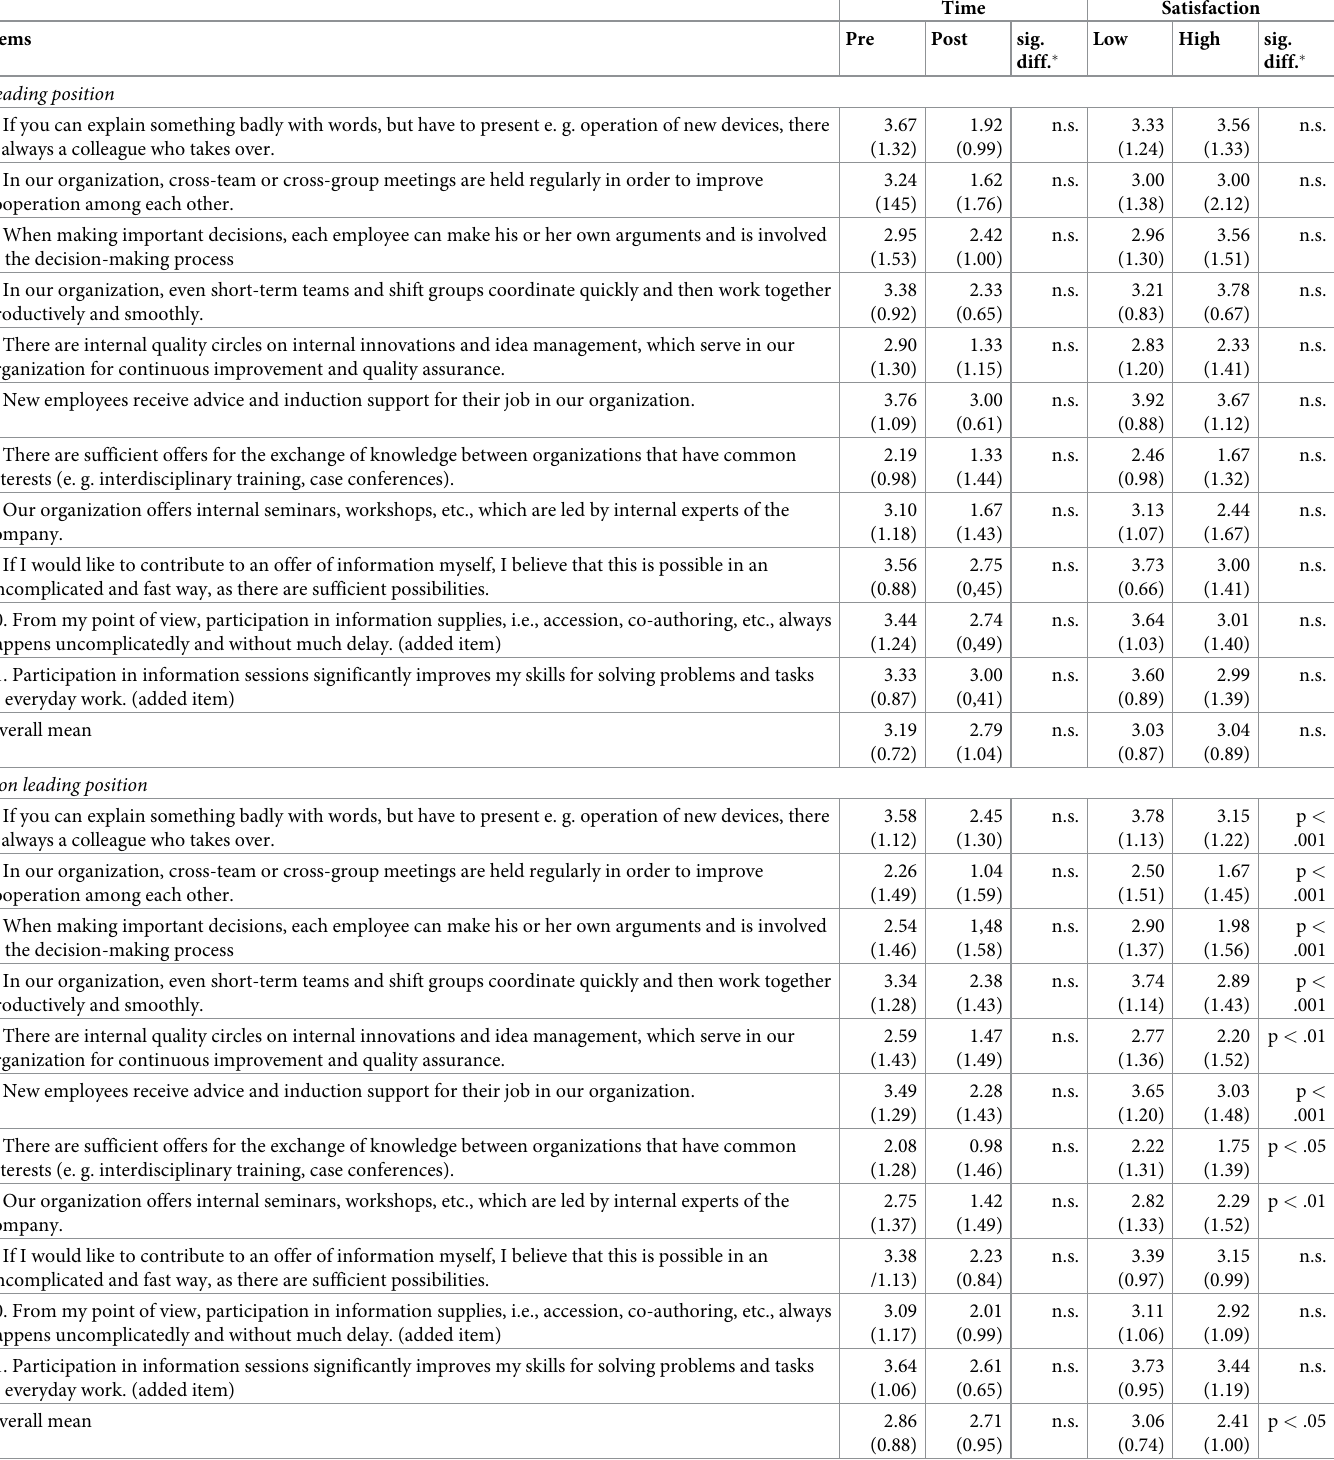
Table 6. Items concerning knowledge transfer with means (and standard deviations) as a function of position (leading vs. non leading), time (pre, post) and satis- faction (low, high). Items Pre Post sig.